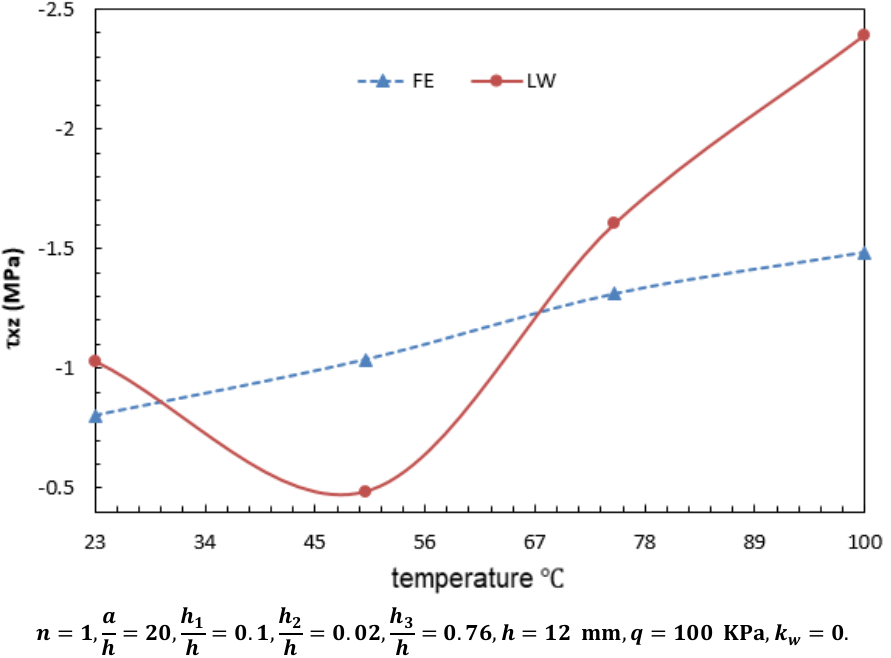
Figure 6. Effect of the thermal loads on the transverse shear stress of sandwich plate (for point 8).